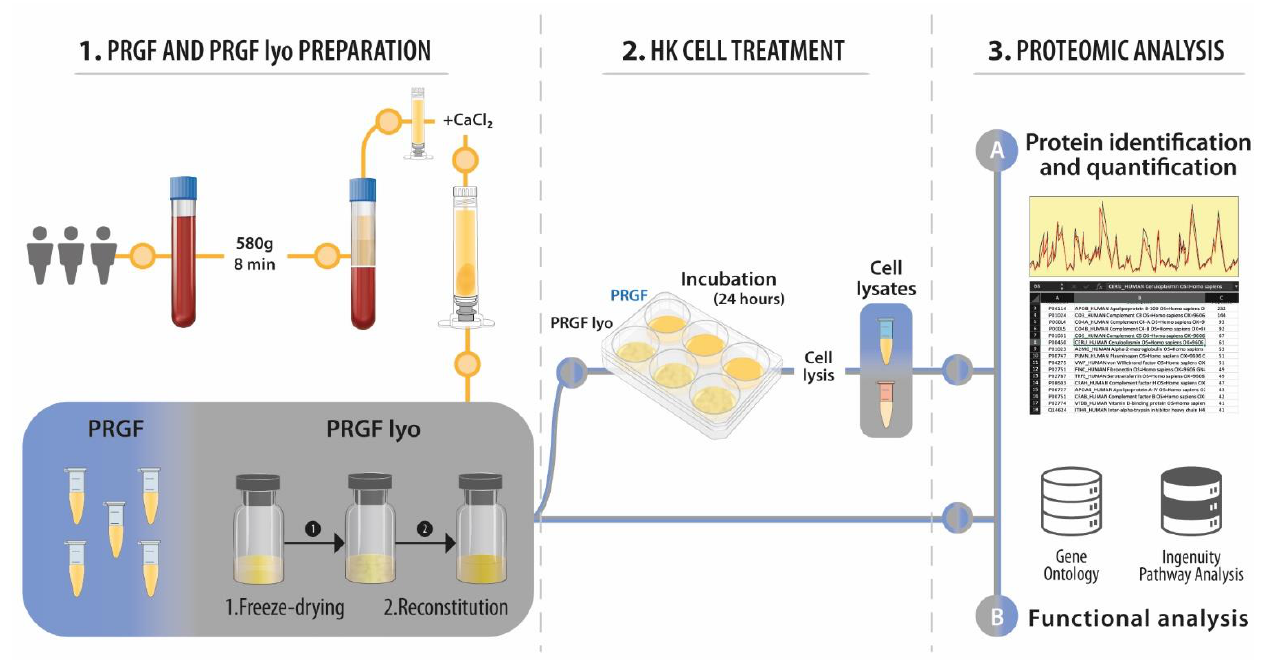
Figure 1. Schematic workflow of the proteomic study of the PRGF and PRGF lyo formulations. The study was divided into three parts; in the first part, the two blood derivatives, PRGF and PRGF lyo, were obtained. In the second part, HK cells were incubated with both blood derived products to analyze by proteomic techniques their response to each formulation. Finally, both PRGF and PRGF lyo were analyzed by the same proteomic techniques.